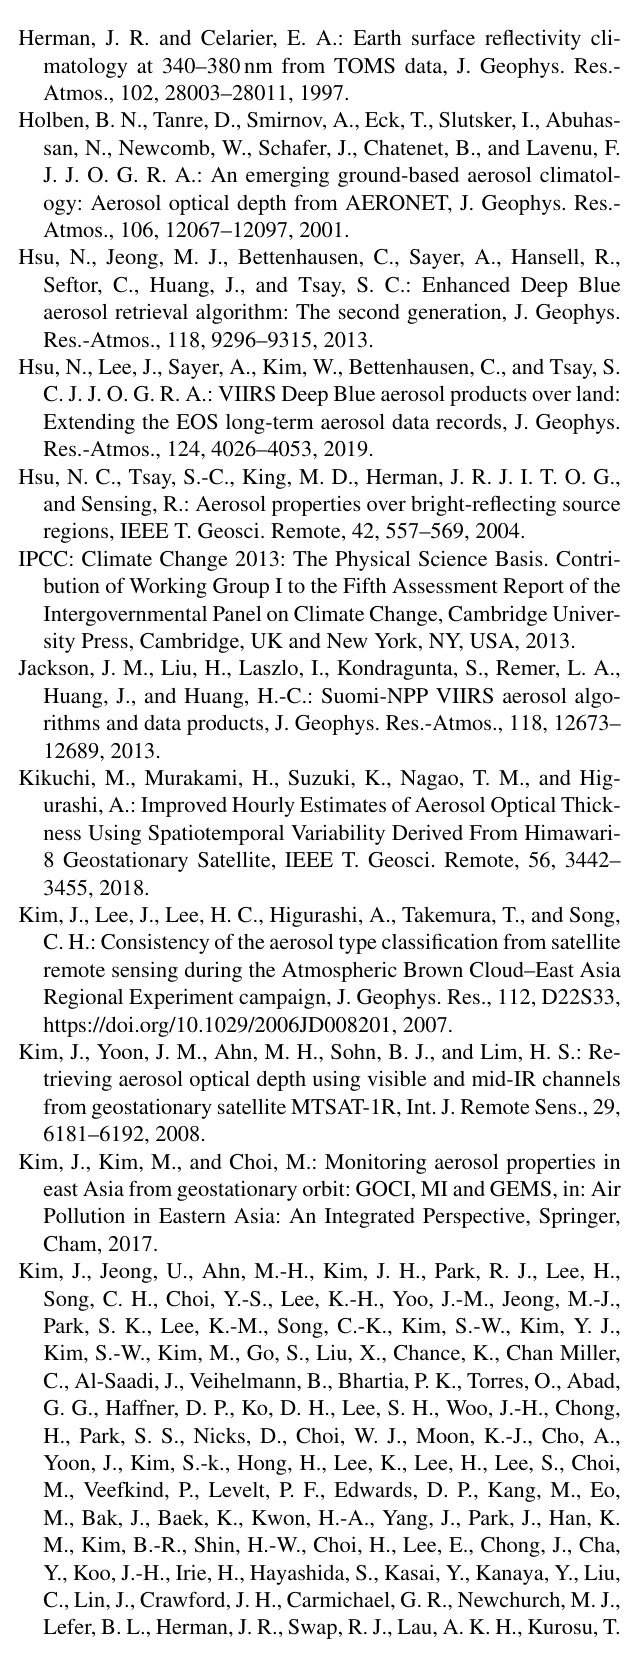
GCOS: Systematic Observation Requirements from Satellite-Based Data Products for Climate 2011 Update. Supplemental